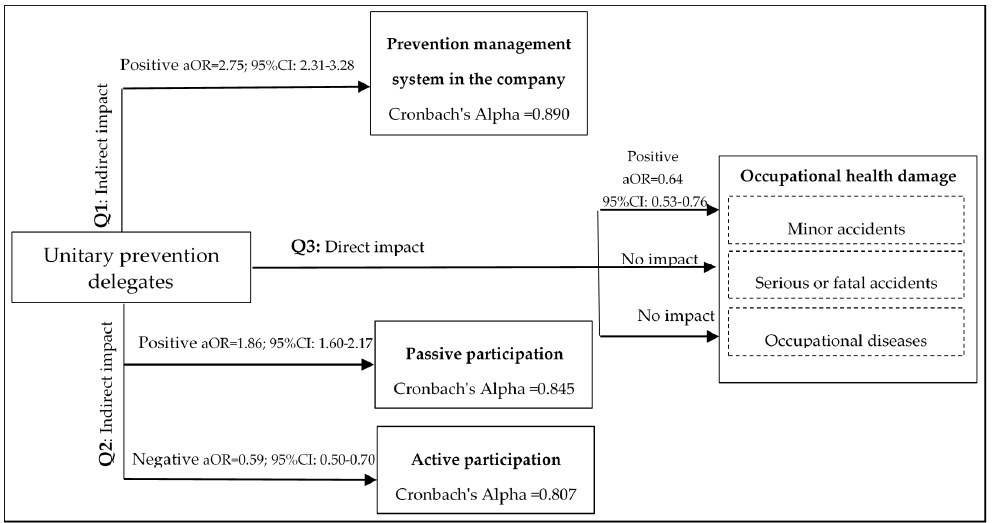
Figure 3. Simplification of the model and summary of results of the Participatory Management System for the Prevention of Occupational Risks. Q1 , first research question; Q2 , second research question; Q3 , third research question; aOR, adjusted odds ratio; 95% CI, 95% confidence interval.